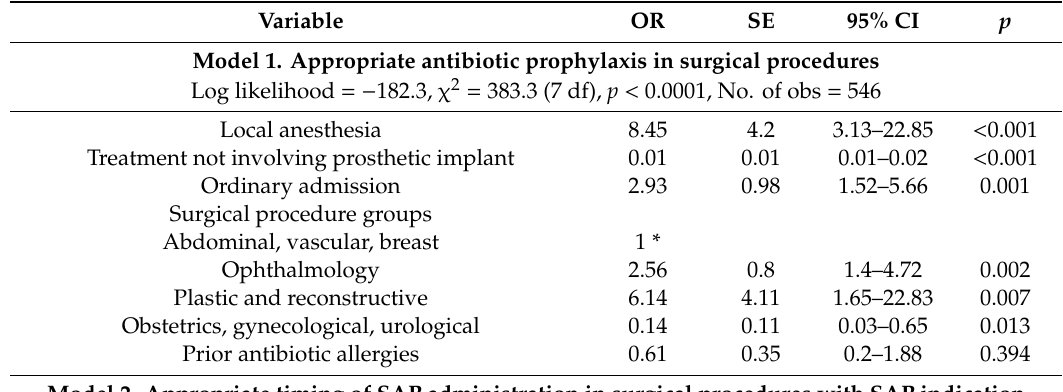
Table 3. Multiple logistic regression analysis results examining appropriate antibiotic prophylaxis in surgical procedures and appropriateness of timing of SAP administration according to several explanatory